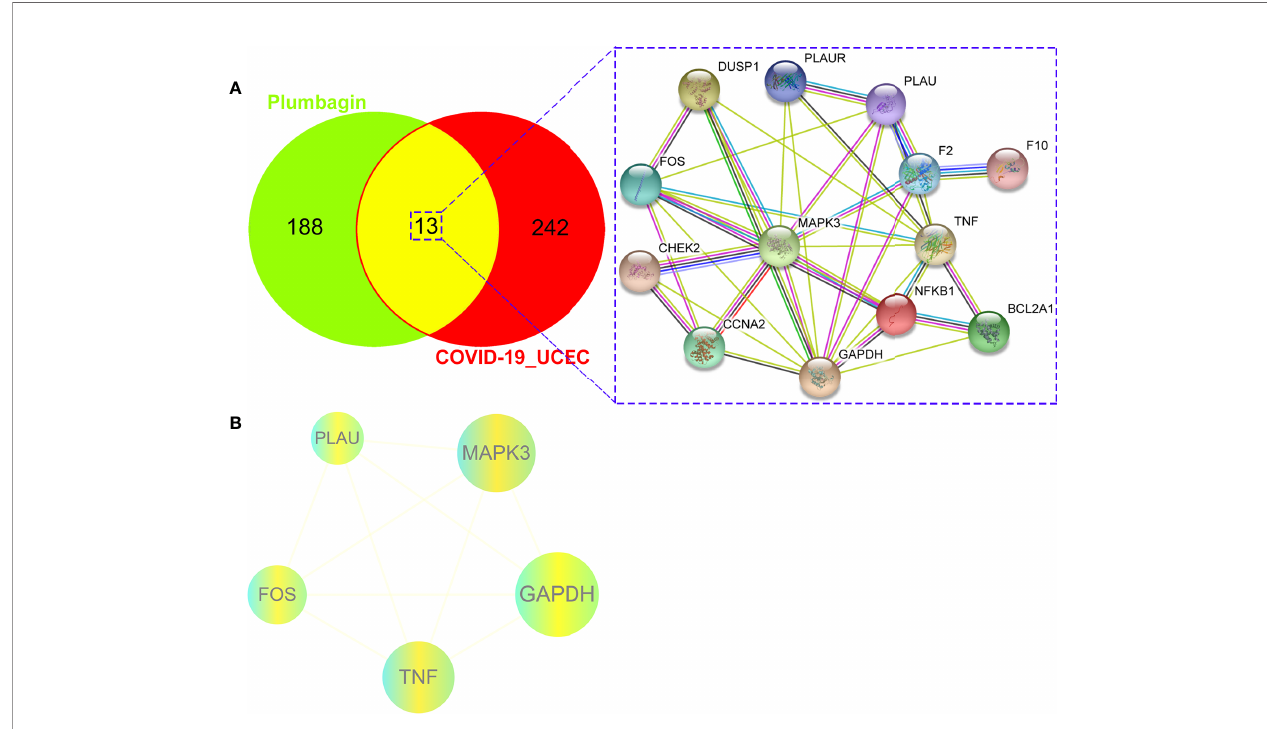
FIGURE 5 | Bioinformatics characteristics of PLB against UCEC/COVID-19. (A), a gene-assayed network connection of PLB against UCEC/COVID-19. (B) , 5 identi fi ed predictive core bio targets of PLB in the potential treatment of UCEC/COVID-19.